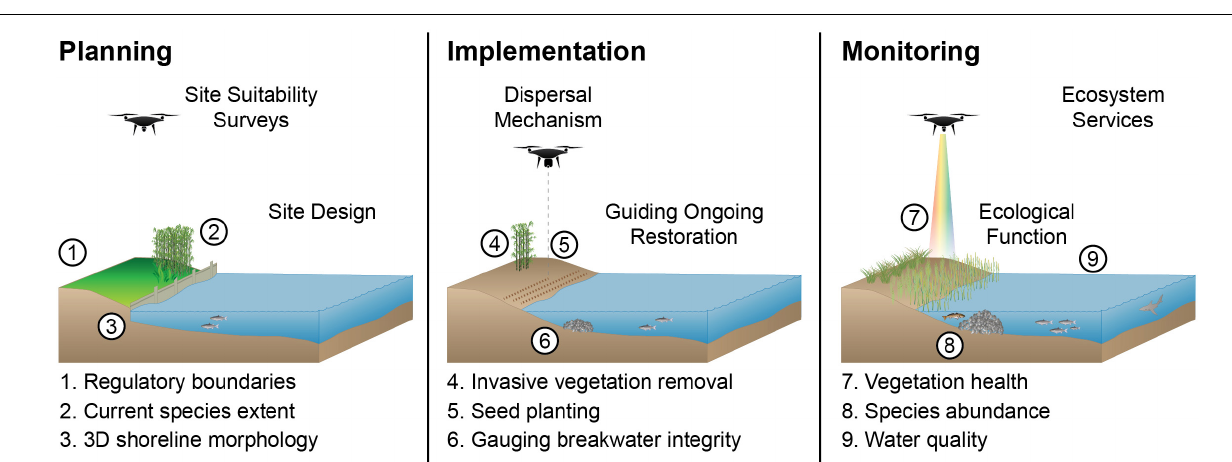
FIGURE 3 | Synopsis of unoccupied aircraft system (UAS) applications in Marine Ecosystem Restoration (MER) projects at the three major stages with select examples provided. The Planning stage includes collecting baseline data to establish regulatory and ecological boundaries (Site Suitability) and generation of visuals and models help determine MER success criteria (Site Design). In the Implementation stage, UASs can be applied for vegetation planting, fire ignition, herbicide or pesticide treatments as well as helping direct ongoing restoration activities. During the Monitoring stage, UASs can collect data on vegetation health, wildlife abundance and behavior (Ecological Function) and data on topography, hydrology, and water quality of the surrounding landscape (Ecosystem Services). Some of the symbols for diagrams courtesy of the Integration and Application Network